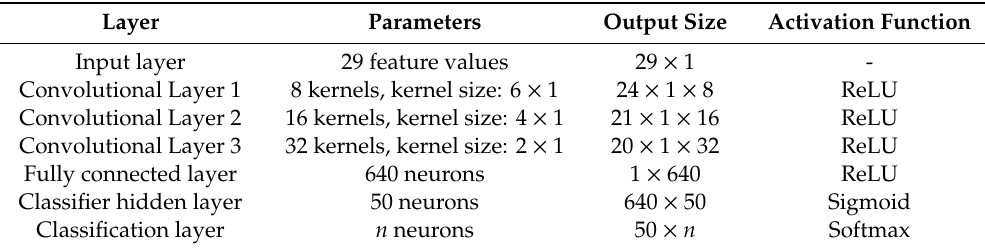
Table 2. Specific setting parameters of the convulational neural network (CNN). Layer Parameters Output Size Activation Function